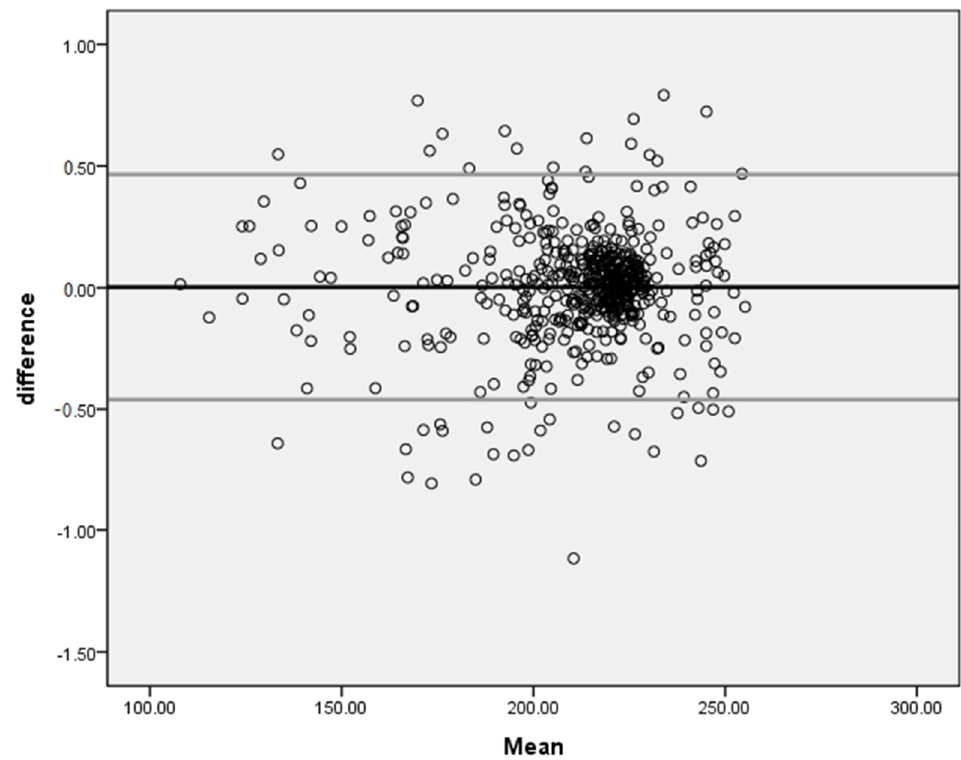
Figure 2. The Bland–Altman plot showing adequate intra-observer reproducibility ( n = 540).